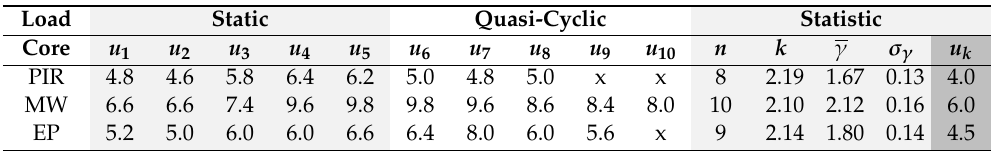
Table 6. Axial pull-out—calculation of the characteristic values of the displacements u k (mm). Load Static Quasi-Cyclic Statistic Core